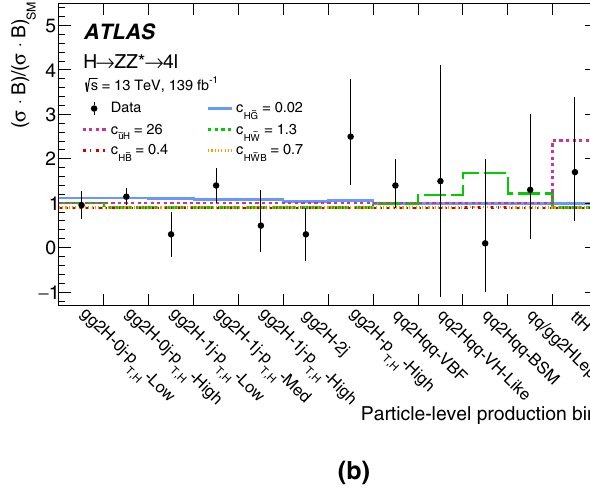
parameter values correspond approximately to the expected confidence intervals at the 68% CL obtained from the statistical interpretation of